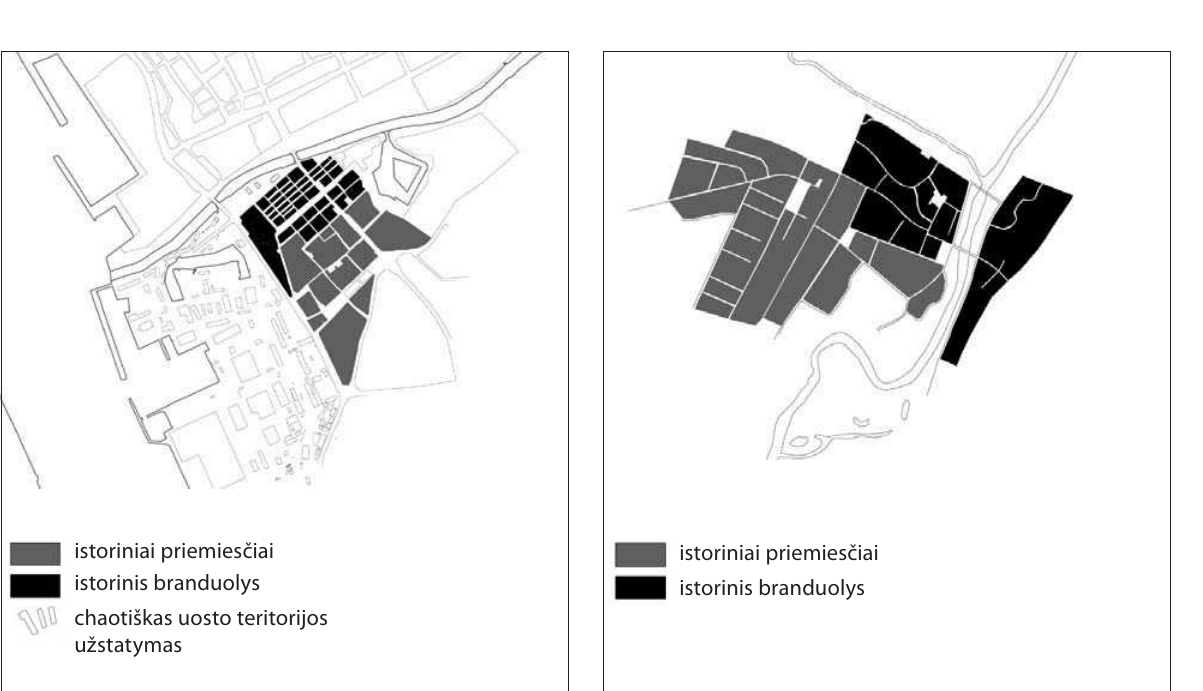
Fig. 4. System of blocks in old